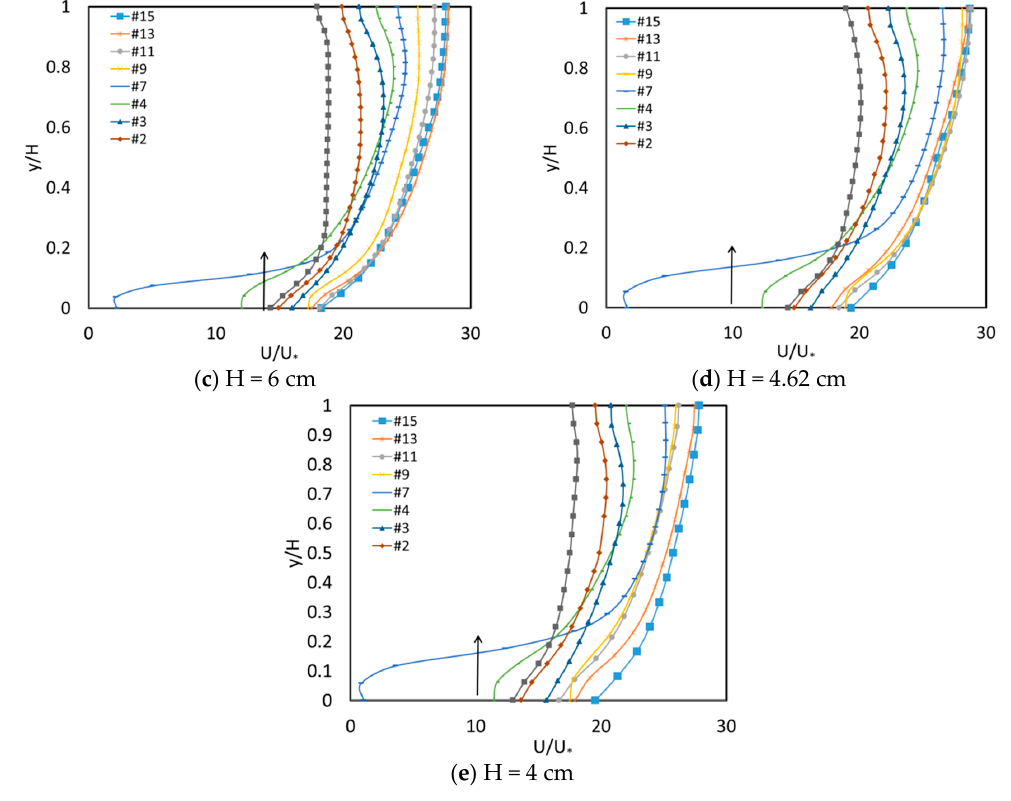
Figure 5. Velocity profile at different water depths.